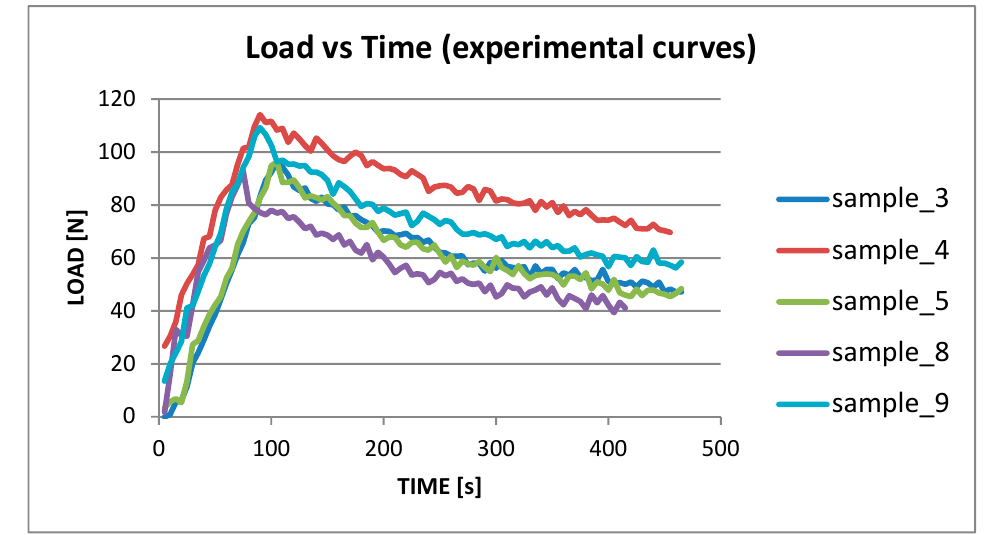
Figure 11. Experimental DCB curves for samples 3, 4, 5, 8, and 9. Table 1. Synoptic of the experimental G I energy values for delamination propagation. BT—beam